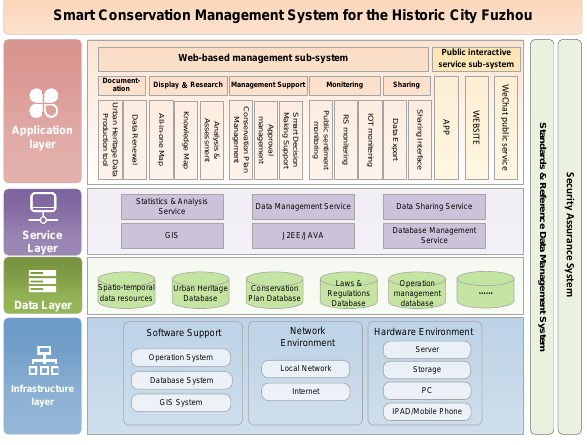
Figure 1. Architecture of the system